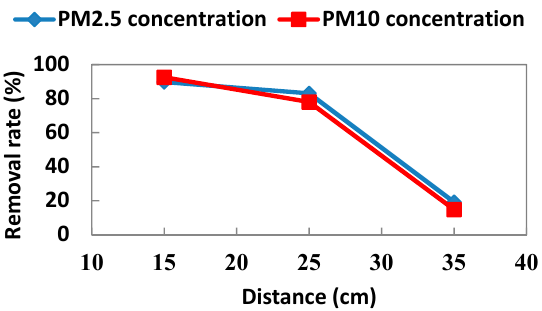
Figure 2. Comparison among the measurements of indoor air particulates from moxibustion emissions inside the acupuncture and moxibustion room with local exhaust ventilation at the distance of 15, 25 and 35 cm far from the combustion sources.